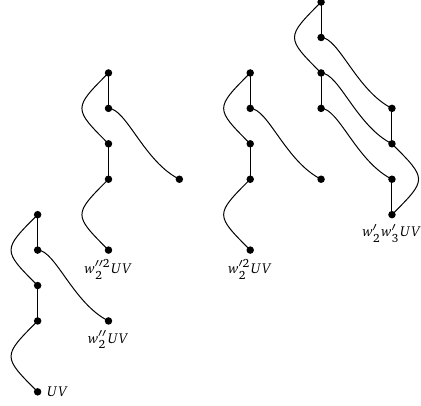
] { UV } , up to degree 12. , w (cid:48) , w (cid:48)(cid:48) 2 3 2